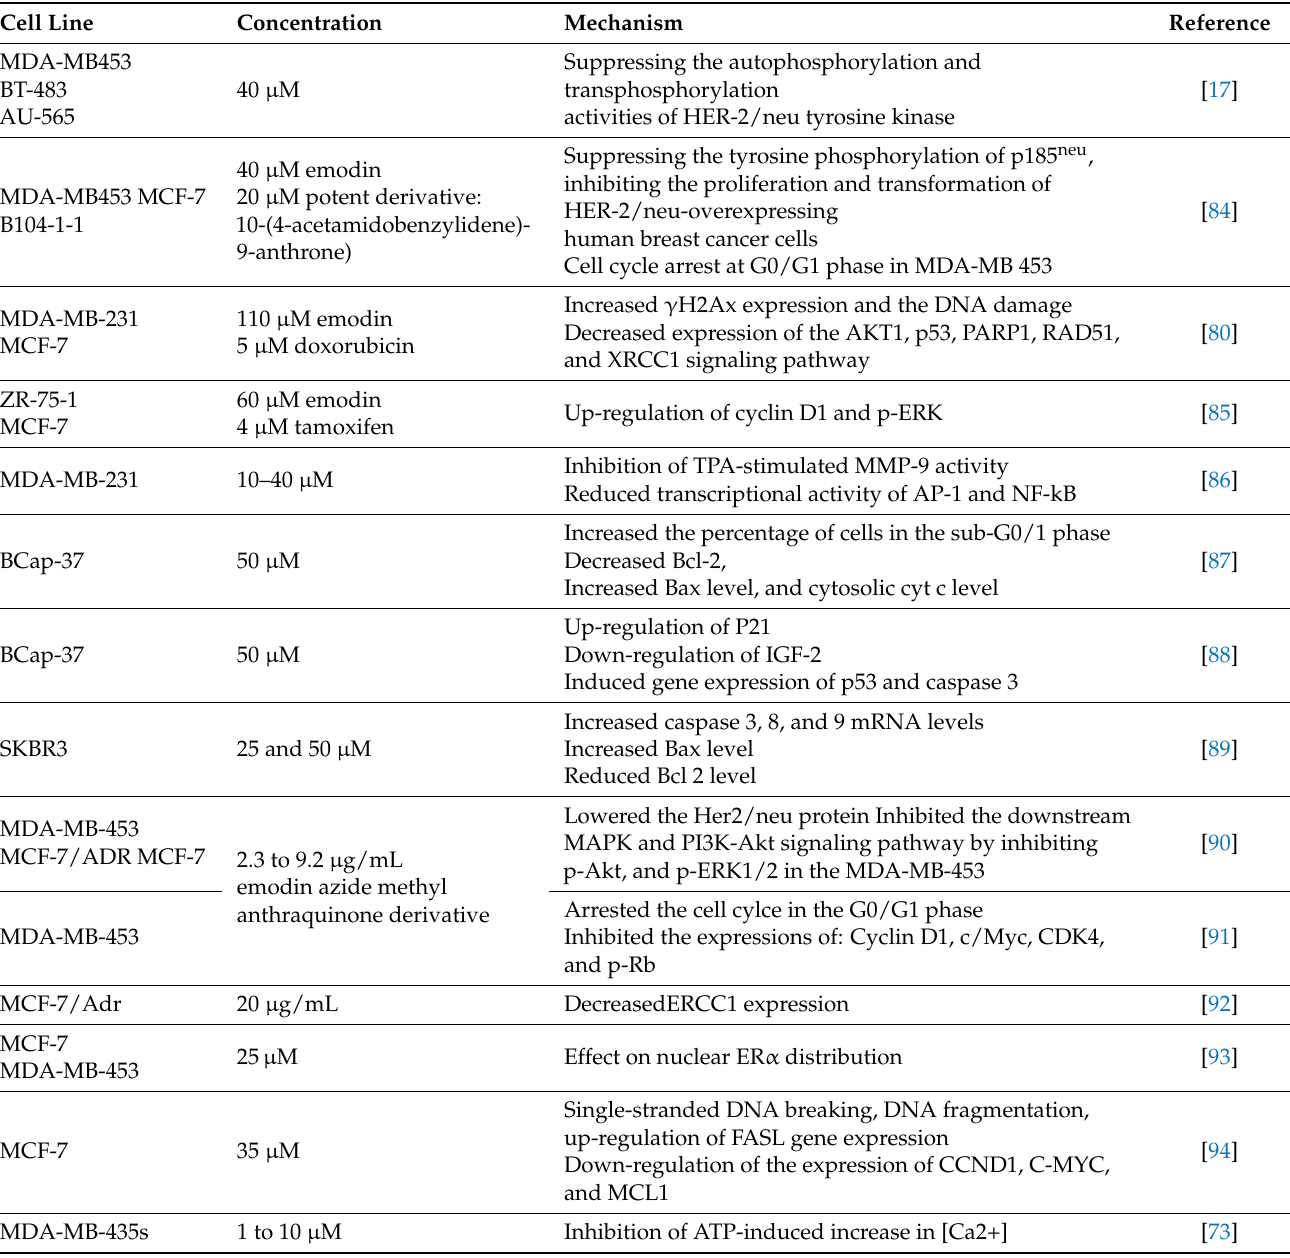
Table 2. Summary of in vitro biochemical effects of emodin in breast cancer cell